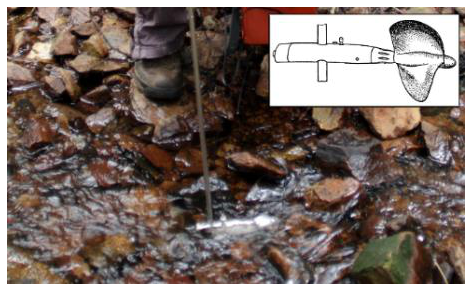
Figure 2: Flow velocity measurement with a propeller gauge: Small image illustrates the propeller gauge from Dyck & Peschke